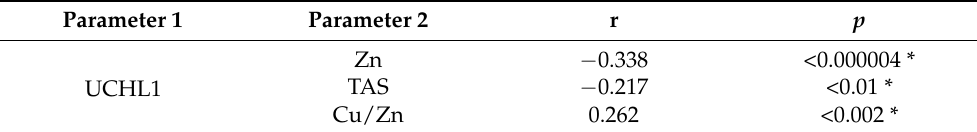
Table 3. Significant correlations between the concentration of UCHL1 and selected parameters. Parameter 1